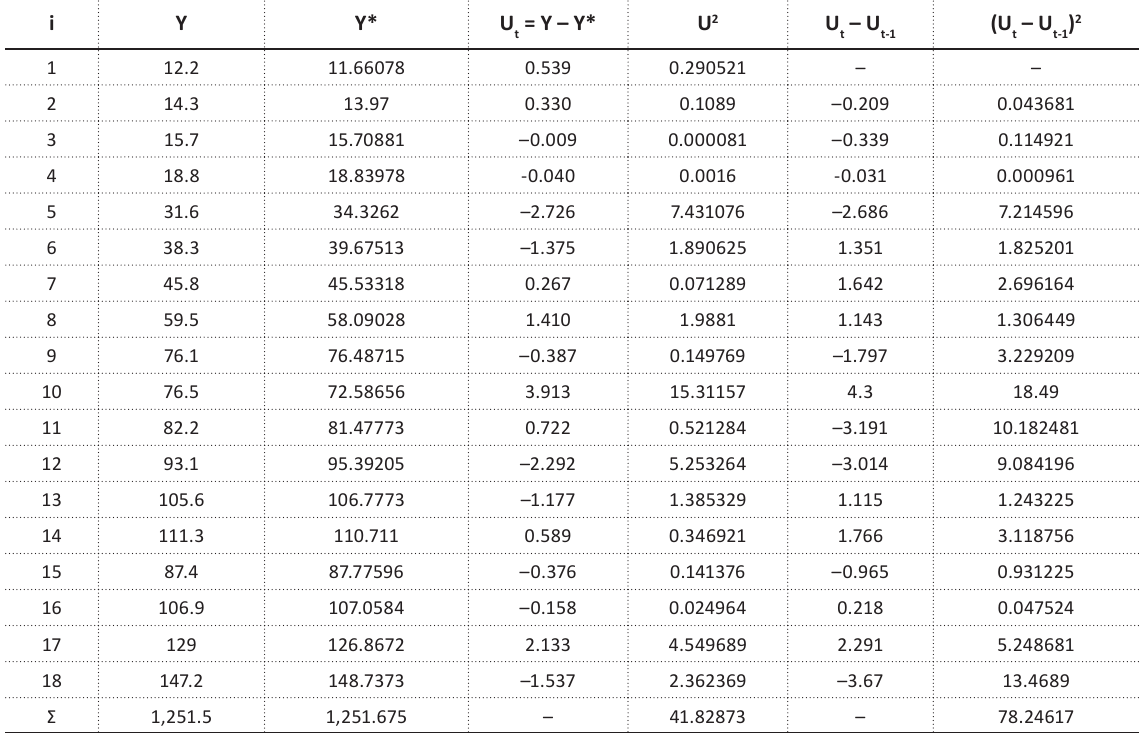
Source: Developed by the